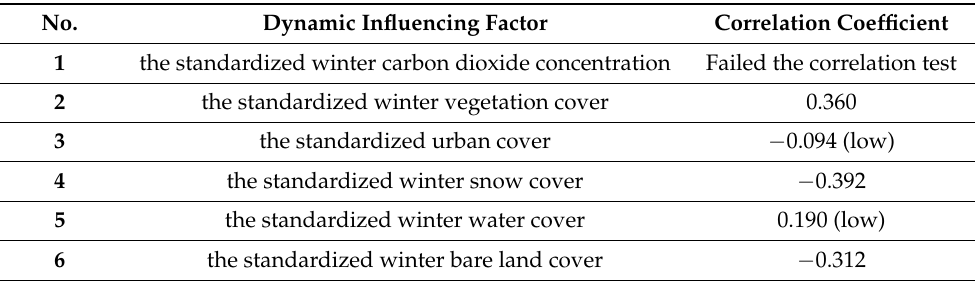
Table 6. Correlation coefficients between the standardized temperature change and dynamic influ- encing factors in